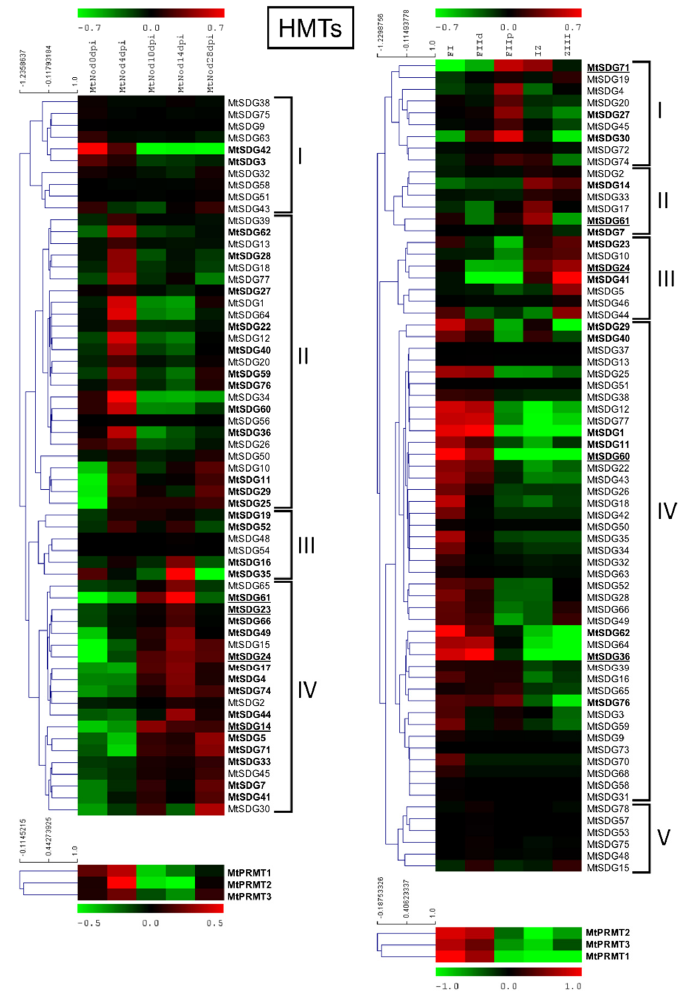
Figure 6. Heat map of MtHMTs in the ND experiment (on the left) and the LCM experiment (on the right). The main clusters are indicated by square brackets. In bold are the genes with an average expression above five in the ND experiment and above two in the LCM experiment. Genes with higher expression are underlined.